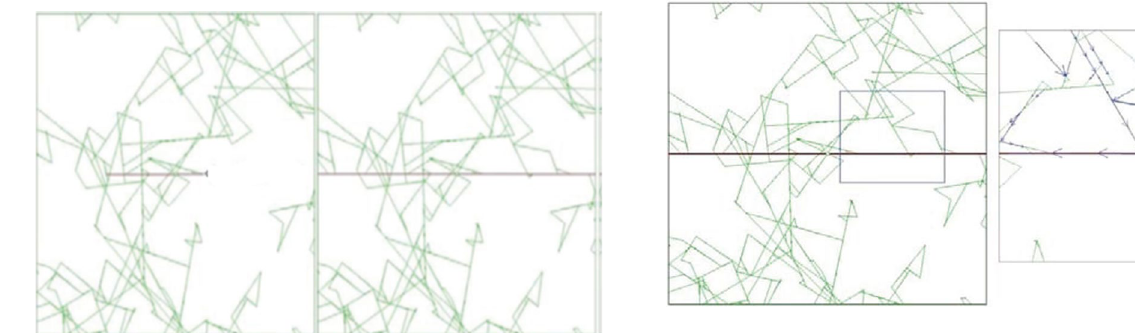
Fig. 12 Hydraulic fracture operations 90° in two different sizes